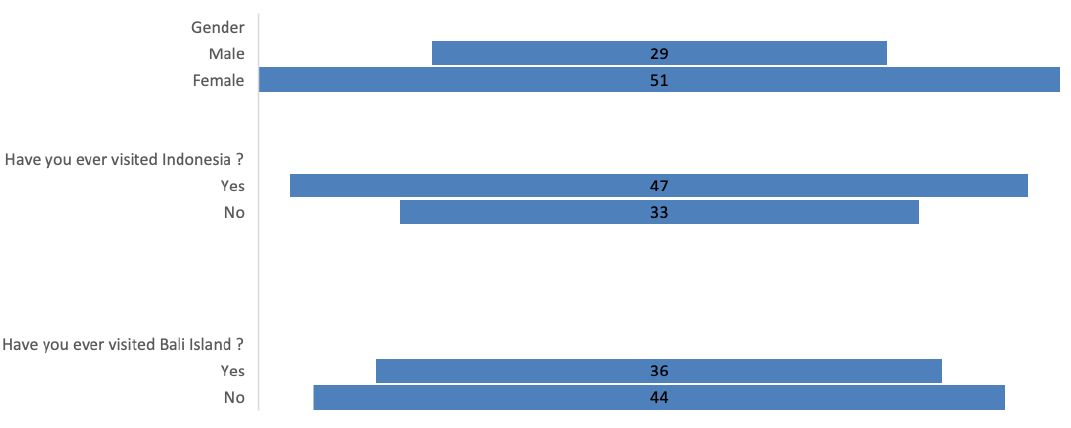
Figure 3. Gender, have or not visited Indonesia and